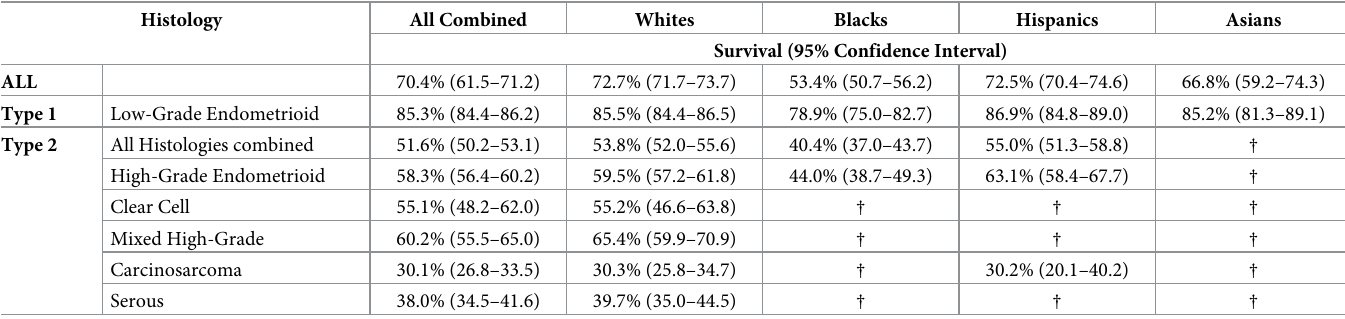
In Table 4, we report the findings of univariable Fine-and-Gray regression models for all EC cases overall and by EC type. We tested the effect of individual variables on the sub-distri- bution hazard function for EC mortality, taking into account death from other causes as the competing risk. Significant predictors included age, race/ethnicity, insurance, poverty level, SEER stage, and histological type. A higher risk of cause-specific death was found for Blacks in Table 3. Age-standardized 5-year EC-specific survival by type, histological subtype, and race/ethnicity. Florida 2005–2016. Histology All Combined